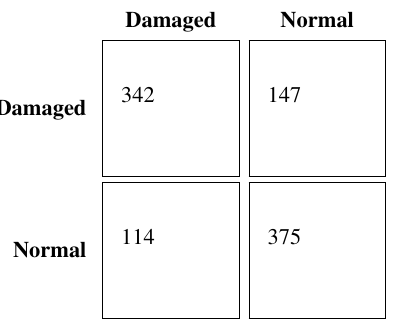
Table 5. Balanced Dataset with data augmentation (rotated images)